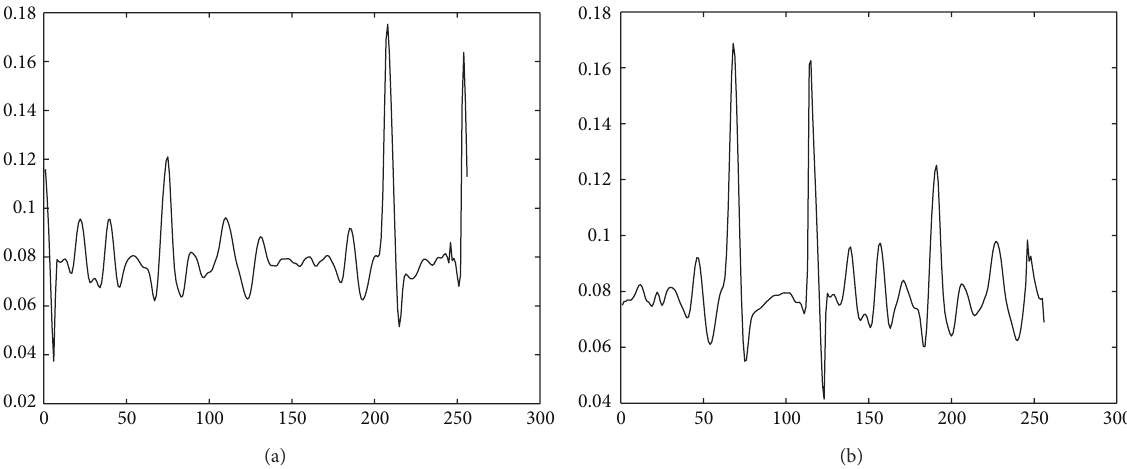
Figure 4: (a) 10-shift curve of the Chinese character given in Figure 2(a). (b) 10-shift curve of the Chinese character given in Figure 3(a).